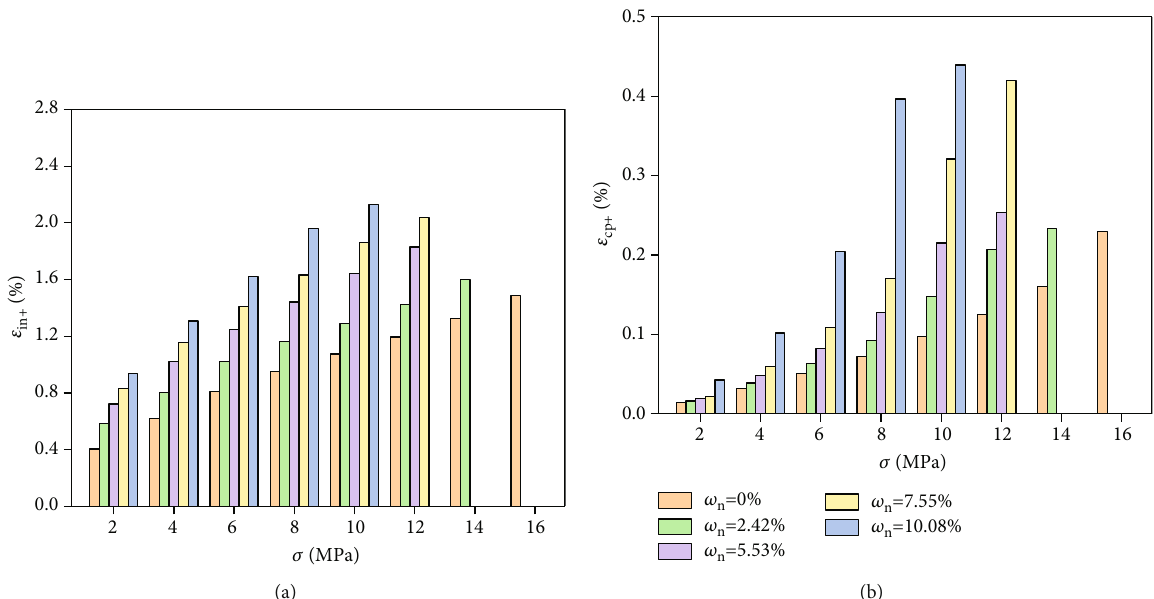
Figure 6: Deformation characteristics under di ff erent water contents and stress levels. (a) Instantaneous strain. (b) Creep strain.